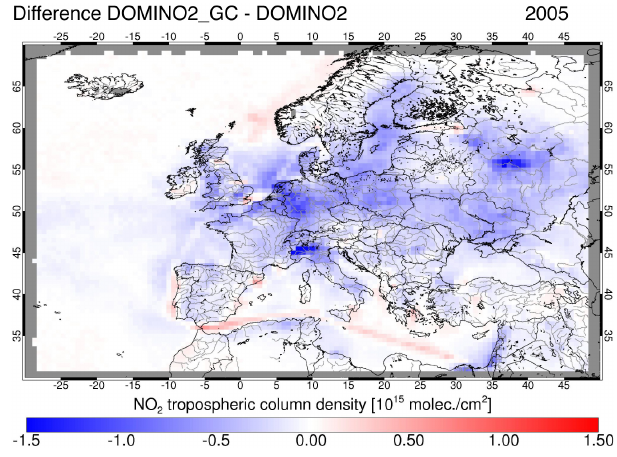
Fig. 5. Differences between annually averaged OMI NO 2 columns for 2005 on a 1 / 2 ◦ × 2 / 3 ◦ resolution using the DOMINO2_GC re- trieval (with a priori NO 2 profiles based on GEOS-Chem 1 / 2 ◦ × 2 / 3 ◦ simulations) and DOMINO2 retrieval (with a priori profiles based on TM4 2 ◦ × 3 ◦ simulations). Selection of OMI observations follows the same criteria as Fig. 3. Differences between these two retrievals arise from different a priori NO 2 profiles, as discussed in Sect. 2.3. The AMFs for these retrievals are shown in Fig.